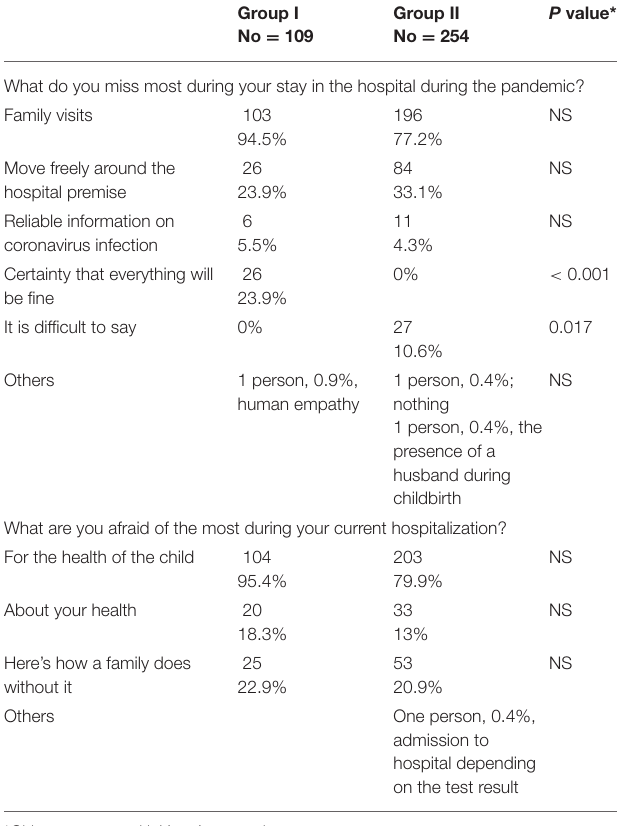
TABLE 2 | Negative feelings of the respondents concerning the hospitalization* multiple answers possible.